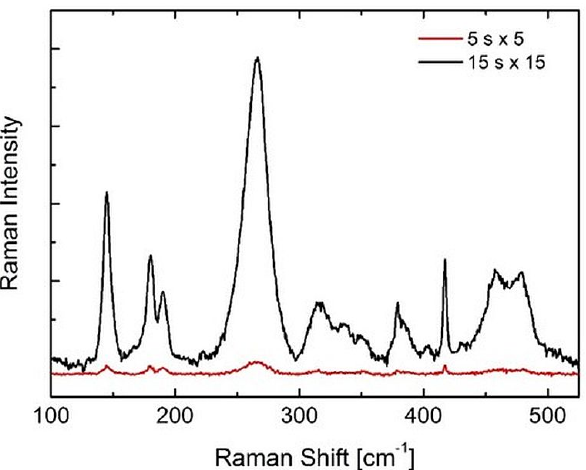
Figure 6. Raman spectra collected on Delta with different acquisition times in order to obtain different SNRs. The spectra were collected on the same point of a polished specimen surface, but the low-SNR spectrum mimics the case of a spectrum collected through a metal layer in correspondence with metal transfer.